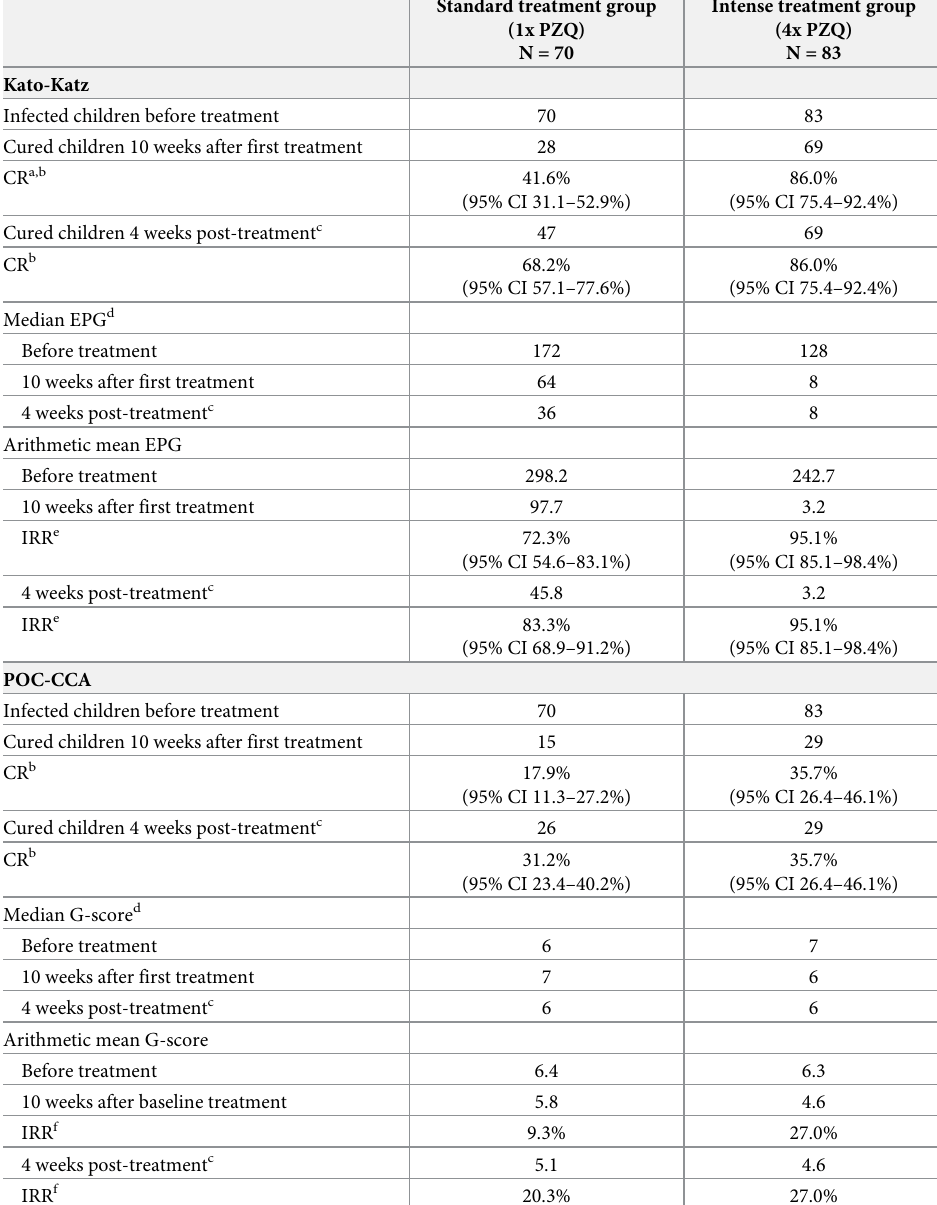
Table 2. Cure rate (CR) and intensity reduction rate (IRR) of a single (standard treatment group) and four (intense treatment group) repeated PZQ treatments in school-aged children infected with S . mansoni . Data are based on triplicate Kato-Katz (KK) thick smears from a single stool sample and single point-of-care circulating cathodic antigen (POC-CCA) urine